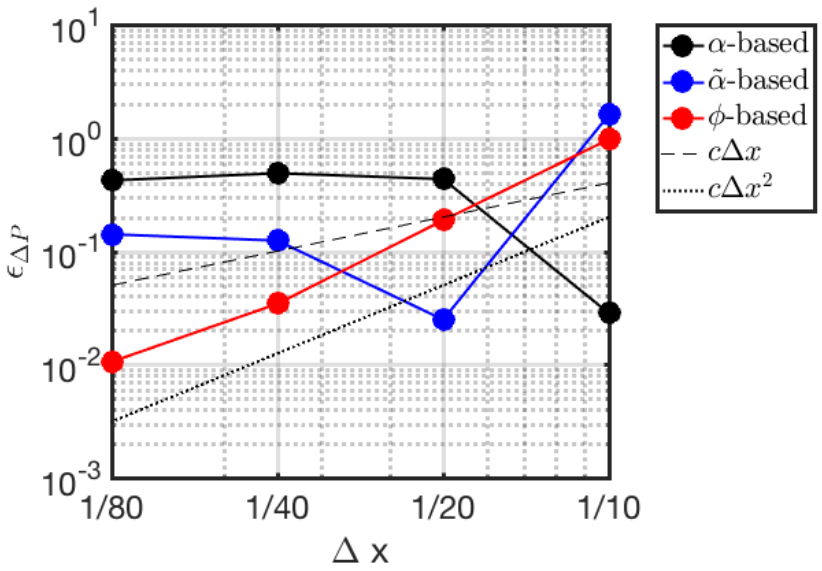
Figure 3. Laplace pressure error for the 2D droplet corresponding to the three curvature schemes. The φ -based method is the only one that produces convergent results to approximately the second